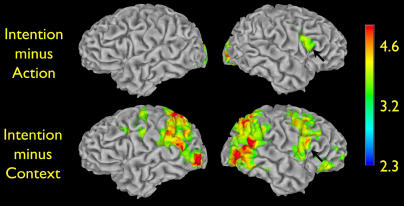
Signal Increases for Intention minus Action and Intention minus ContextThreshold of Z = 2.3 at voxel level and a cluster level corrected for the whole brain at p < 0.05. The black arrow indicates the only area showing signal increase in both comparisons. The area is located in the dorsal sector of pars opercularis, where mirror activity has been repeatedly observed [10,11,12,13,14,15,16,17,18,19,20,27]. See Tables S1 and S2 for coordinates of local maxima.